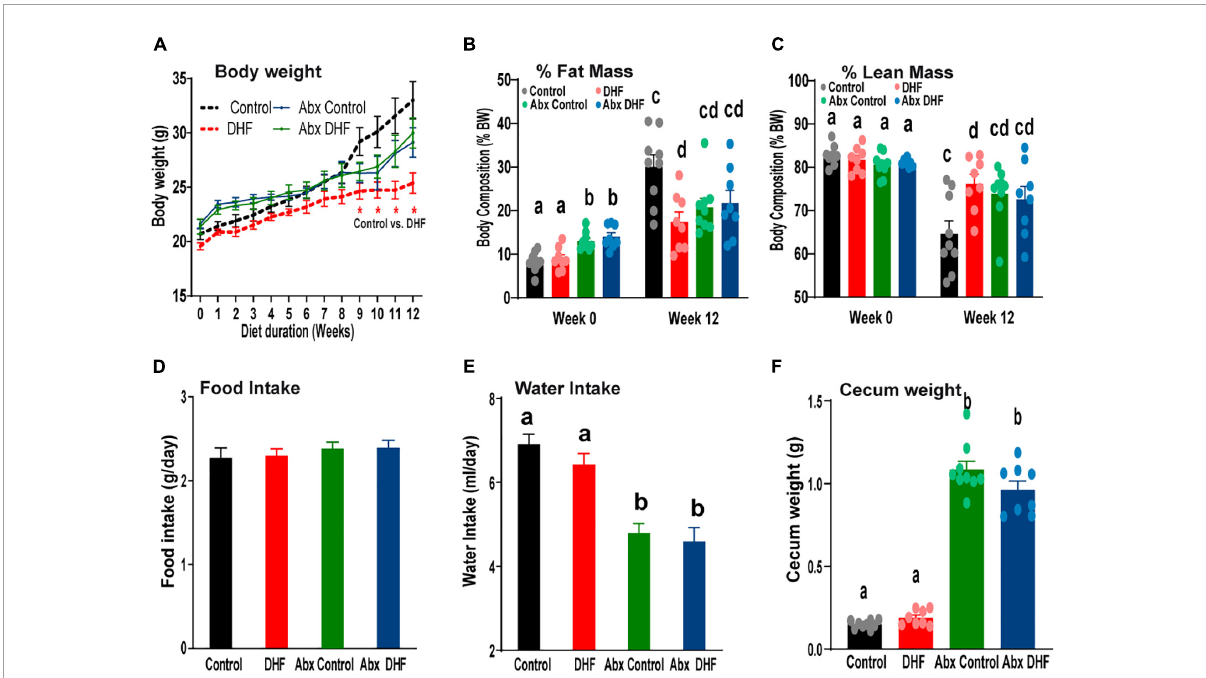
FIGURE1 Gut microbiome ablation prevents improvement in metabolism by DHF. (A–C) Conventionally raised and Abx-treated females were maintained on a high-fat diet (HFD), supplemented with or without oral 7,8-DHF (1 mg/mL) for 12 weeks. Body weights were measured weekly, and initial and terminal body compositions were measured by NMR. (D,E) Food and water intake were measured weekly and biweekly, respectively. (F) Cecum weights were measured at the end of 12 weeks. Data were analyzed by one way ANOVA followed by Bonferroni post hoc comparison. Groups with different letters are significantly different from each other. * p < 0.05 for Control vs. DHF. Data are expressed as average ± SEM ( n = 8–9).